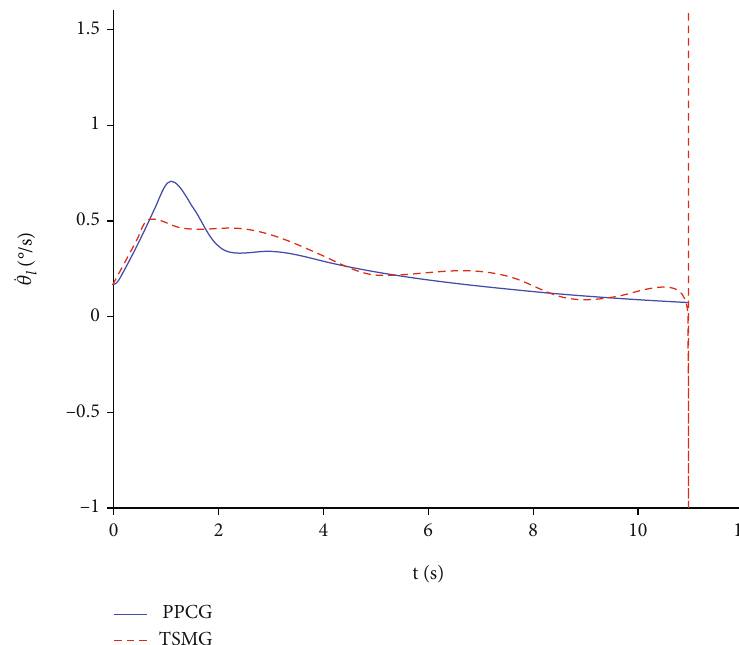
Figure 18: Comparison of LOS angular rate